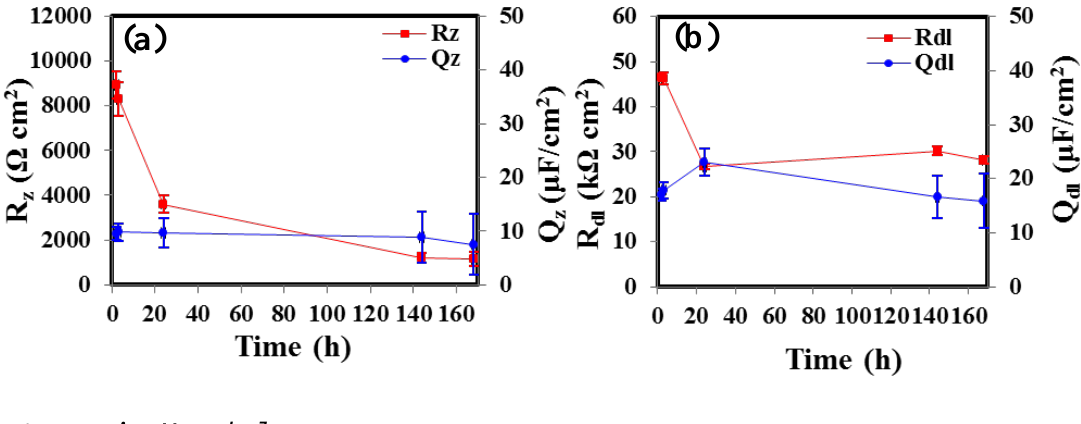
Figure 7. Temporal evolution of the different parameters associated with the proposed EEC for the zeolite coated AZ91D alloy at different durations of immersion in 0.1 M NaCl